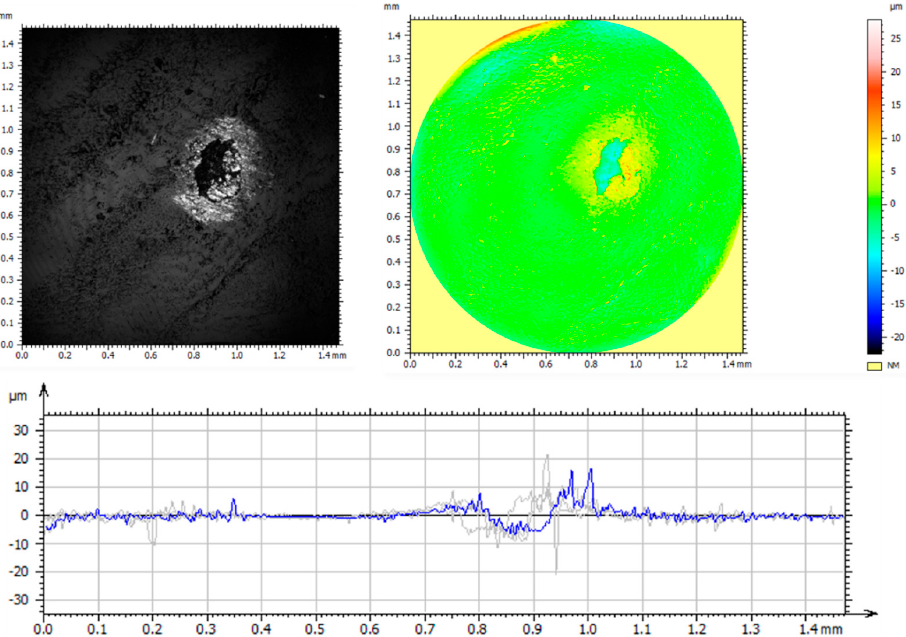
Figure 18. Optical and axonometric views of ball wear track and the wear profile on transverse cross-section after the RS- lubricated sliding of the nitrogen ion-implanted steel 316L—Al 2 O 3 friction pair.